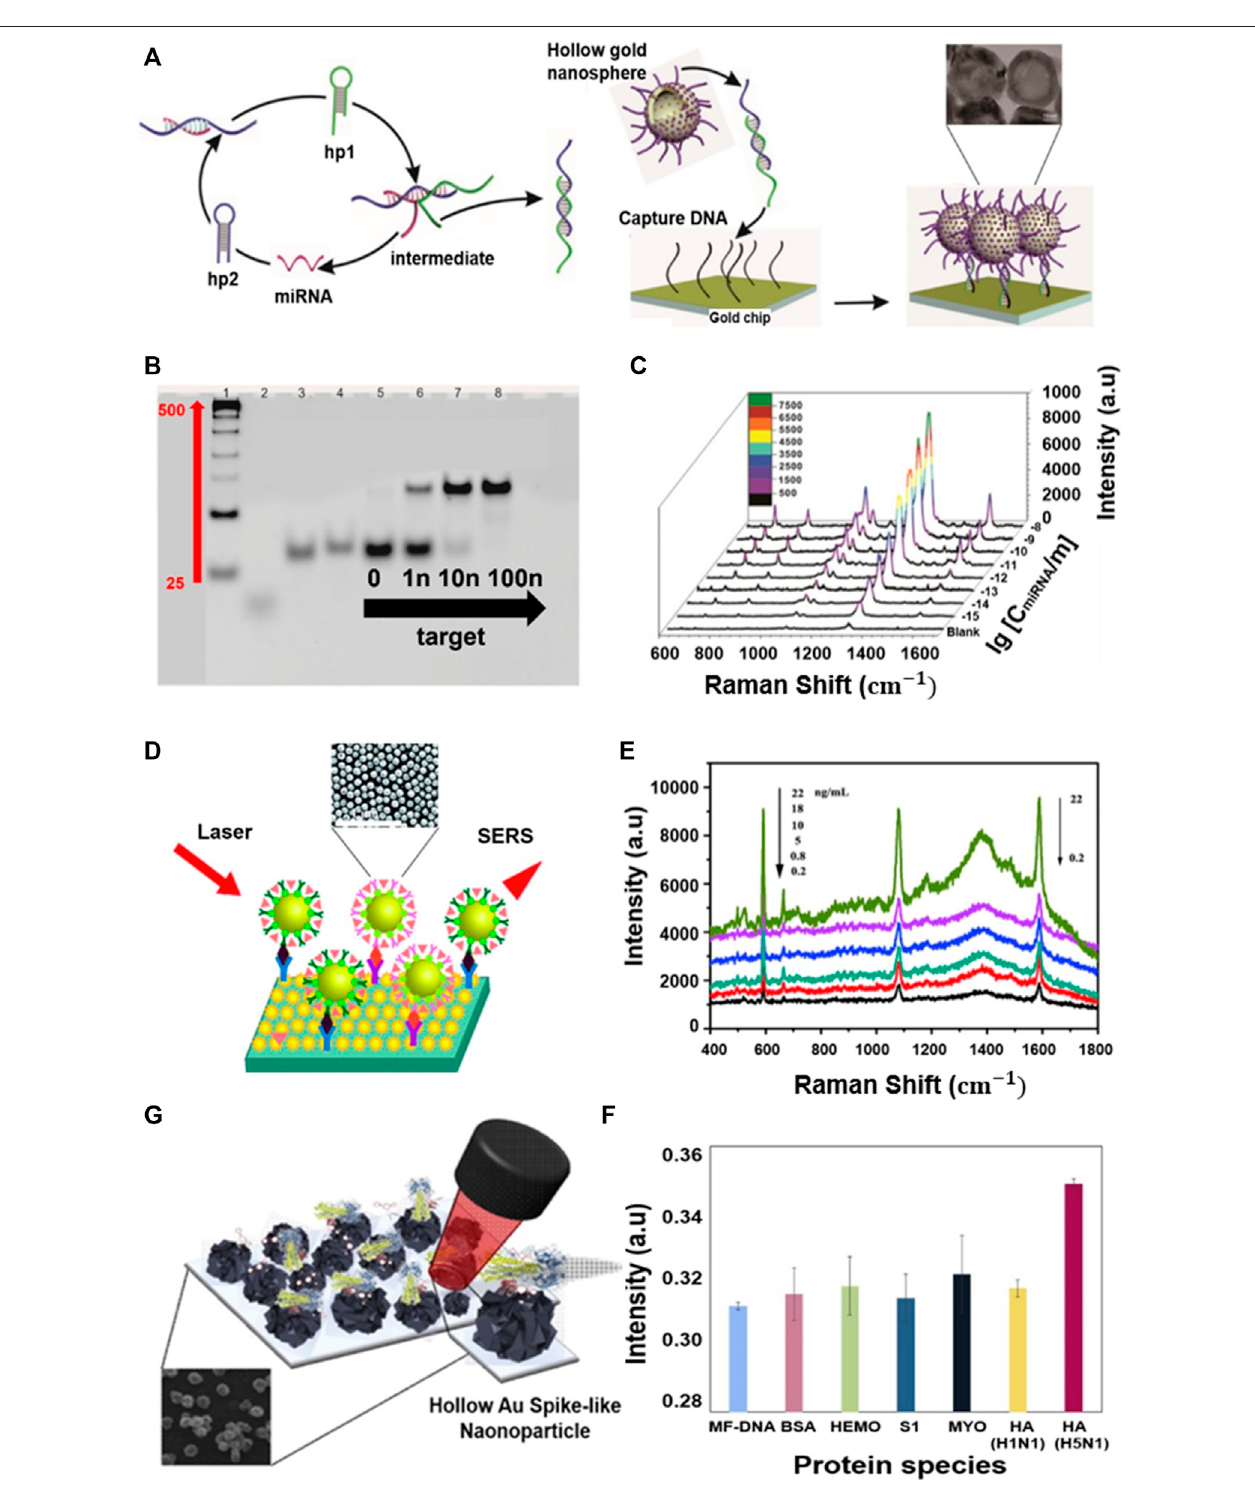
FIGURE 8 | miRNA-detection biosensor for acute myocardial infarction diagnosis. (A) Target-catalyzed hairpin assembly process and fi nal structure for the surface-enhanced Raman spectroscopy detection platform. (B) Polyacrylamide gel electrophoresis results of the miR-133a-powered DNA molecular machine. (C) Representative SERS spectra corresponding to miR-133a with varying concentrations. Biosensor to detect brain damage-related proteins. (D) Illustration of SERS- based immunoassay for neuron-speci fi c enolase (NSE) and S100 calcium-binding protein beta (S100- β ) detection. (E) SERS spectra of the multiplex immunosensor after incubation with various concentrations of S100- β and NSE. Biosensor utilizing DNA to detect avian in fl uenza virus. (F) Schematic image of the